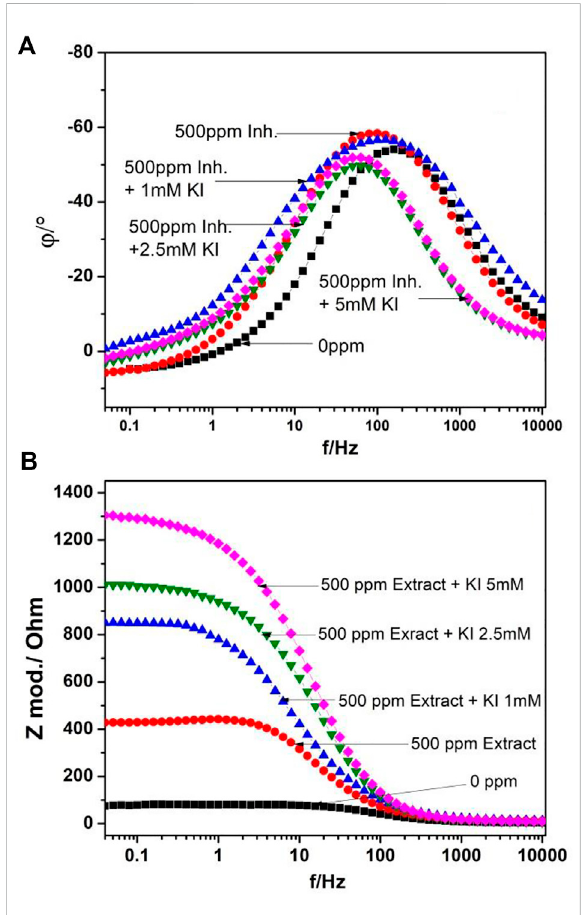
FIGURE 2 Bode diagrams for 1018 steel corrosion in acid media when adding 500 ppm of M. sativa at different KI concentrations (A) phase diagram and (B) module diagram.